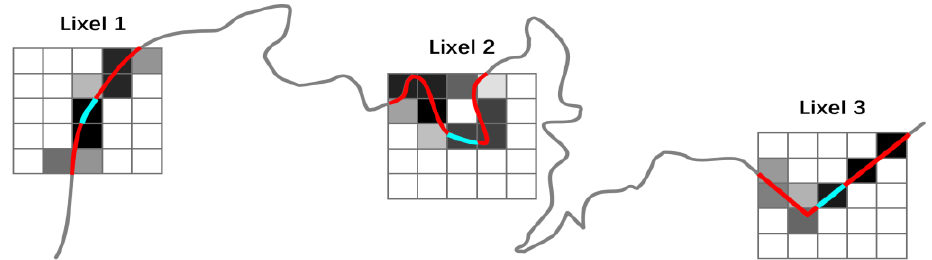
Figure 5. Grid shape context descriptors (GSCDs) with 5 × 5 cells for describing the contextual characteristics of three different lixels (in green) on an administrative boundary.